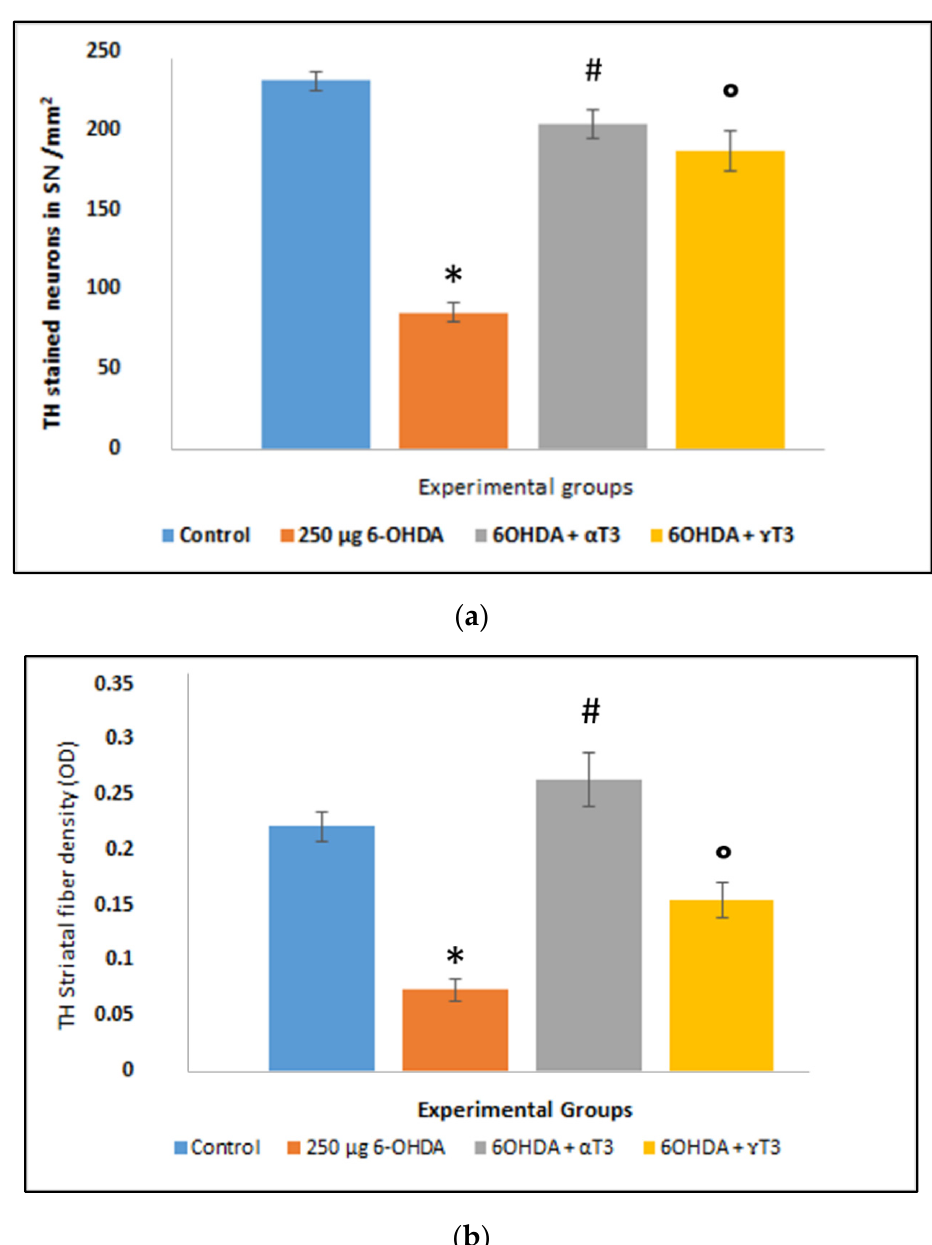
Figure 5. Bar chart representing the ( a ) average number of tyrosine hydroxylase (TH)-immunostained dopamine neurons in the substantia nigra, and ( b ) TH-immunostained striatal fibre density (optical density (OD)) quantified using ImageJ. ( n = 6; * p < 0.05 vs. control; # p < 0.05 vs. 250 µ g 6-OHDA; ◦ p < 0.05 vs. 250 µ g